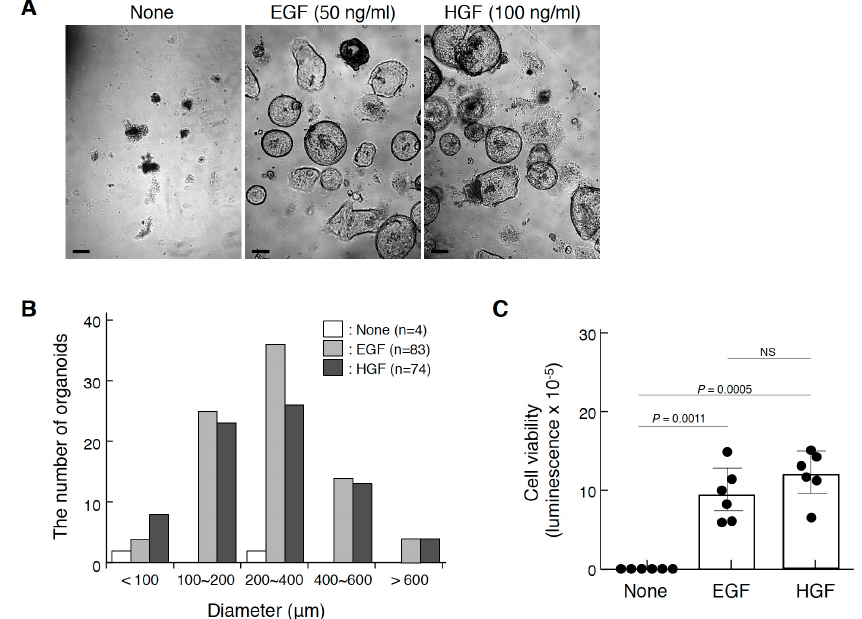
Figure 7. Promotion of gastric corpus organoids by HGF. ( A ) The appearance of organoids cultured in the absence or presence of EGF or HGF. Scale bars represent 200 µ m. ( B ) The size distribution of organoids. ( C ) The viability of organoids. In ( A ), corpus gland stem cells isolated from a C57BL / 6 mouse were cultured in Matrigel in the absence or presence of EGF (50 ng / mL) or recombinant HGF (100 ng / mL) for 21 days. In ( B ), the size distribution was analyzed by using Image-J. In ( C ), the viability was measured using the CellTiter-Glo ® 3D cell viability assay. Values are presented as mean ± S.D. ( n = 6). Data were tested for significance using an unpaired two-tailed t -test. NS, not significant. Organoid culture was performed twice, from which similar results were obtained.